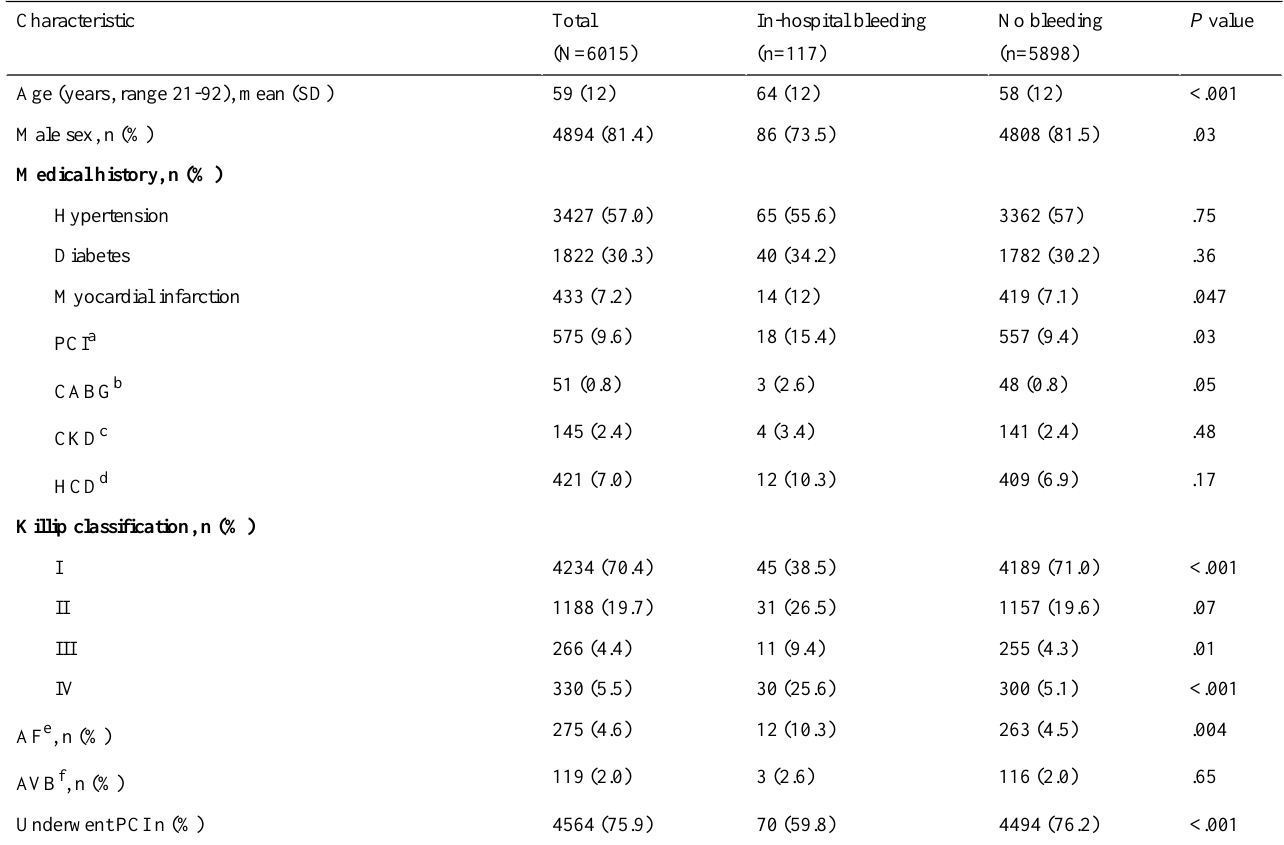
Table 4. Demographic and clinical characteristics of patients with and without in-hospital bleeding in the validation data set